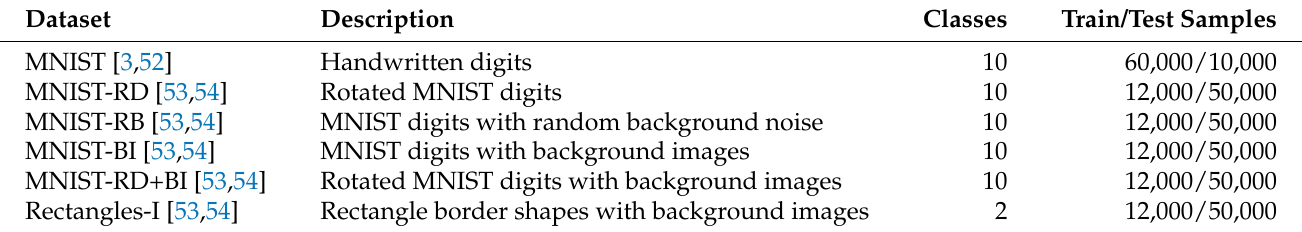
Table 3. A summary of the datasets used in our experiments. All datasets have an input size of 28 × 28 × 1 [51].